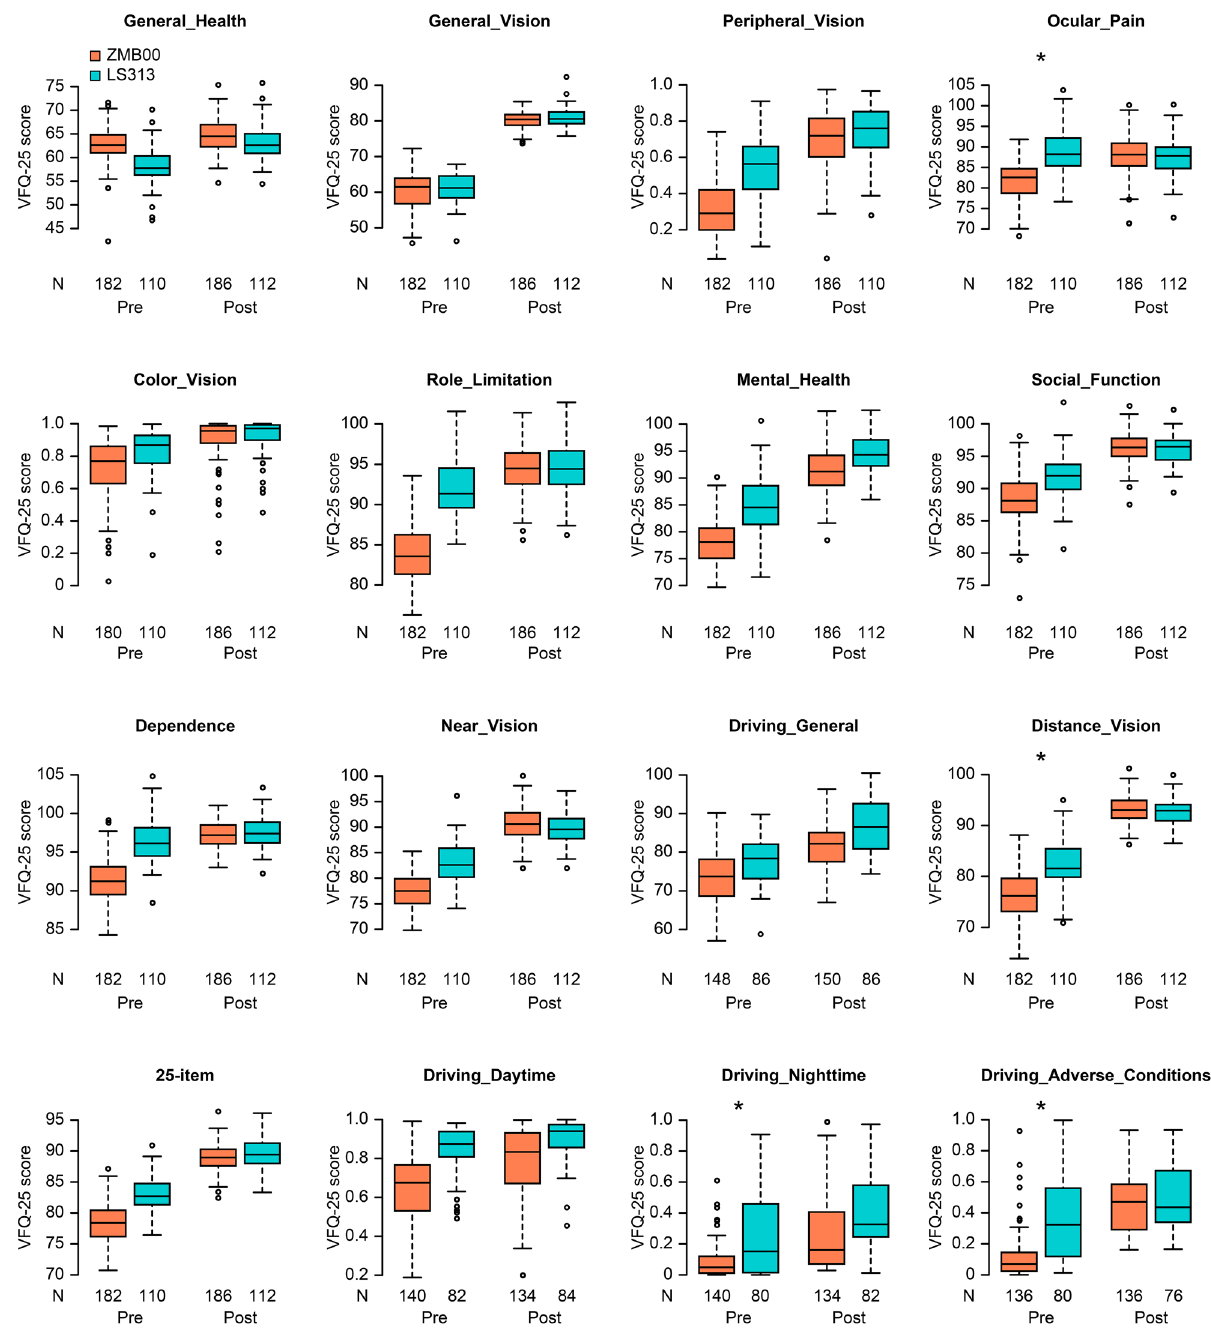
Figure 3. VFQ-25 scores in the diffractive bifocal (TECNIS ZMB00) and rotationally asymmetric refractive (Lentis Comfort LS-313 MF15) groups before and 10 weeks after surgery in both eyes. In the box-and-whisker plots, the bottom of the box indicates the first quartile, and the top of the box indicates the third quartile. The band inside the box represents the median. To highlight suspected outliers, the upper whisker indicates the maximum or the third quartile + 1.5 × IQR, while the lower whisker indicates the minimum or the first quartile-1.5 × IQR. Each parameter was adjusted by multiple linear regression with the explanatory variables in Table 1. The two-sided Wald test was applied to evaluate the significance of differences between the two groups, and the significance level was set to 0.003125 after Bonferroni’s correction. The asterisk * in this figure indicates a significant difference between the two groups satisfying p < 0.003125. In this figure, the predicted values for the following variables were the probabilities of whether the score was over 75 points: Peripheral_Vision, Color_ Vision, Driving_Daytime, Driving_Nighttime, and Driving_Adverse_Conditions. Therefore, the y-axis scale of the figure for these variables is from 0 to